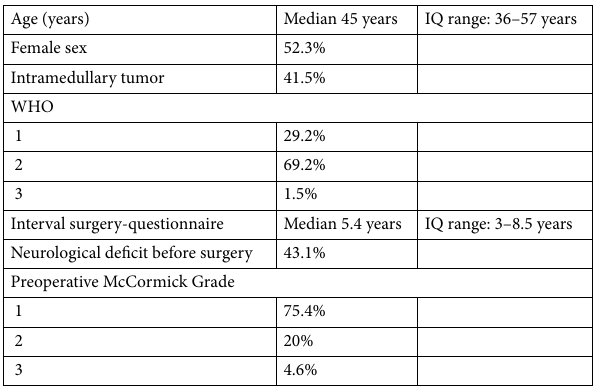
Table 1. Demographics of the studied population including age at diagnosis, gender, location of the tumor, WHO° grading, time duration between surgery and follow-up questionnaires and presence of neurological deficits before surgery.